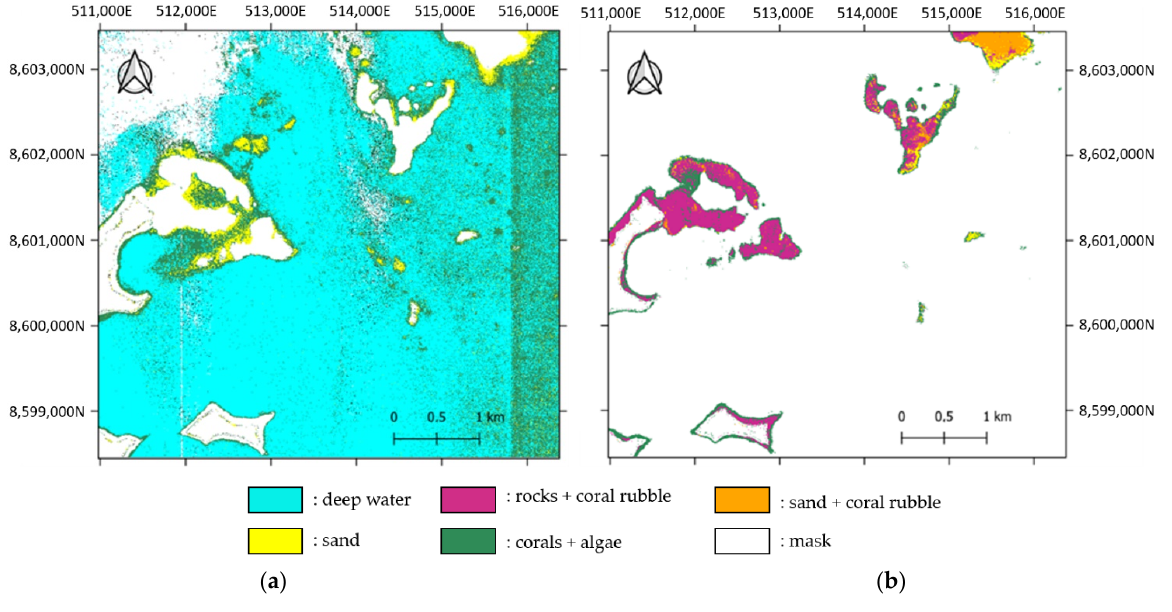
Figure 11. Maps of benthic habitats in the study area. ( a ) Classification map generated using the SVM with the slope geomorphic predictor. This map corresponds to depths shallower than 3.8 m and is based on all three spectral bands (R, G, and B); ( b ) classification map generated with the ML classifier and the three geomorphic predictors. This map corresponds to depths in the range of 3.8–15 m and is based on two spectral bands (G and B).